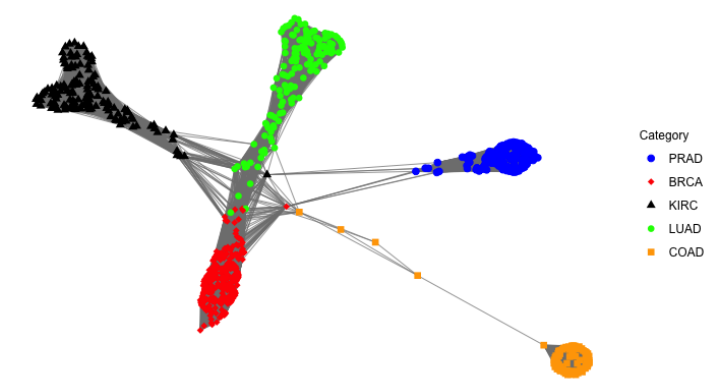
Figure 7. Cluster plot using